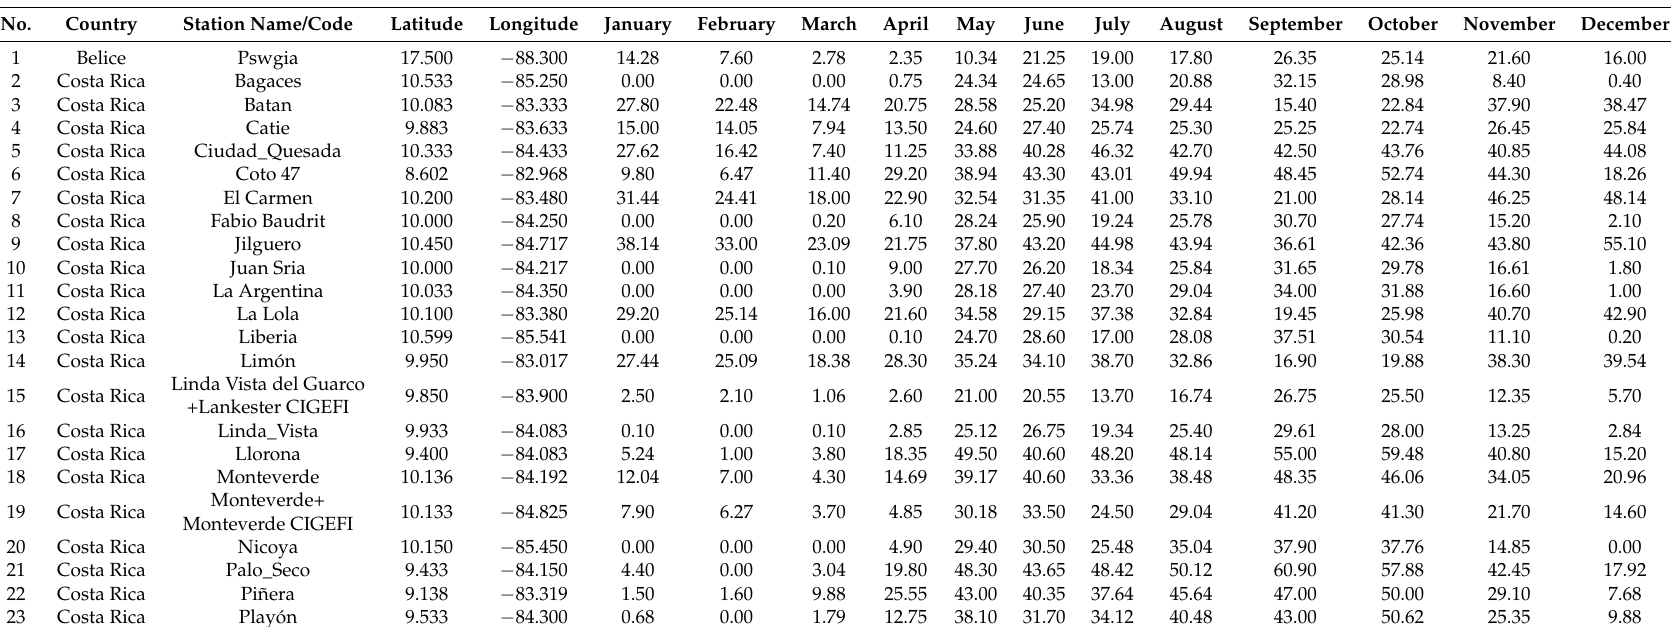
Table 2. Station metadata and 90th percentiles [mm/day] by